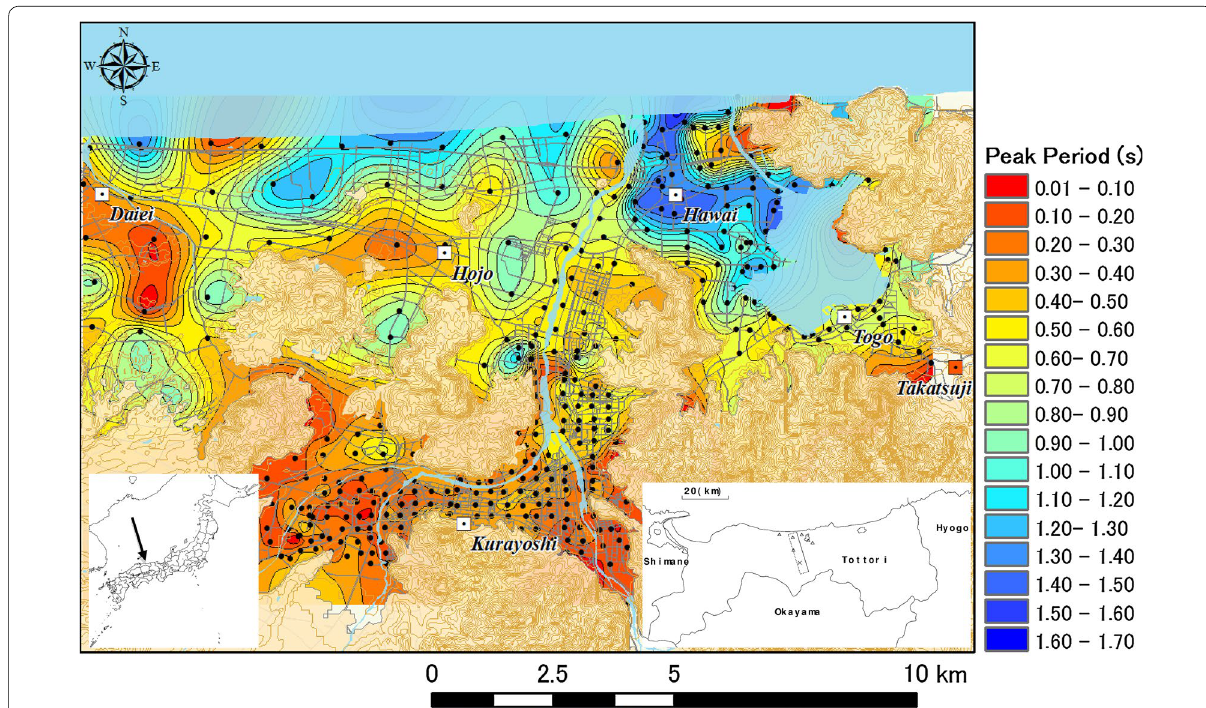
Fig. 1 Distribution map of the predominant periods of the ground surface and locations of strong motion observation sites. The black dots indicate the locations at which microtremors were observed. The bottom left panel indicates the location of the Tottori Prefecture in Japan. The bottom right panel shows a broad area map with prefecture borders. The sites ( rectangular ), epicenter (cross), and estimated fault (GSI 2016) are also shown in the